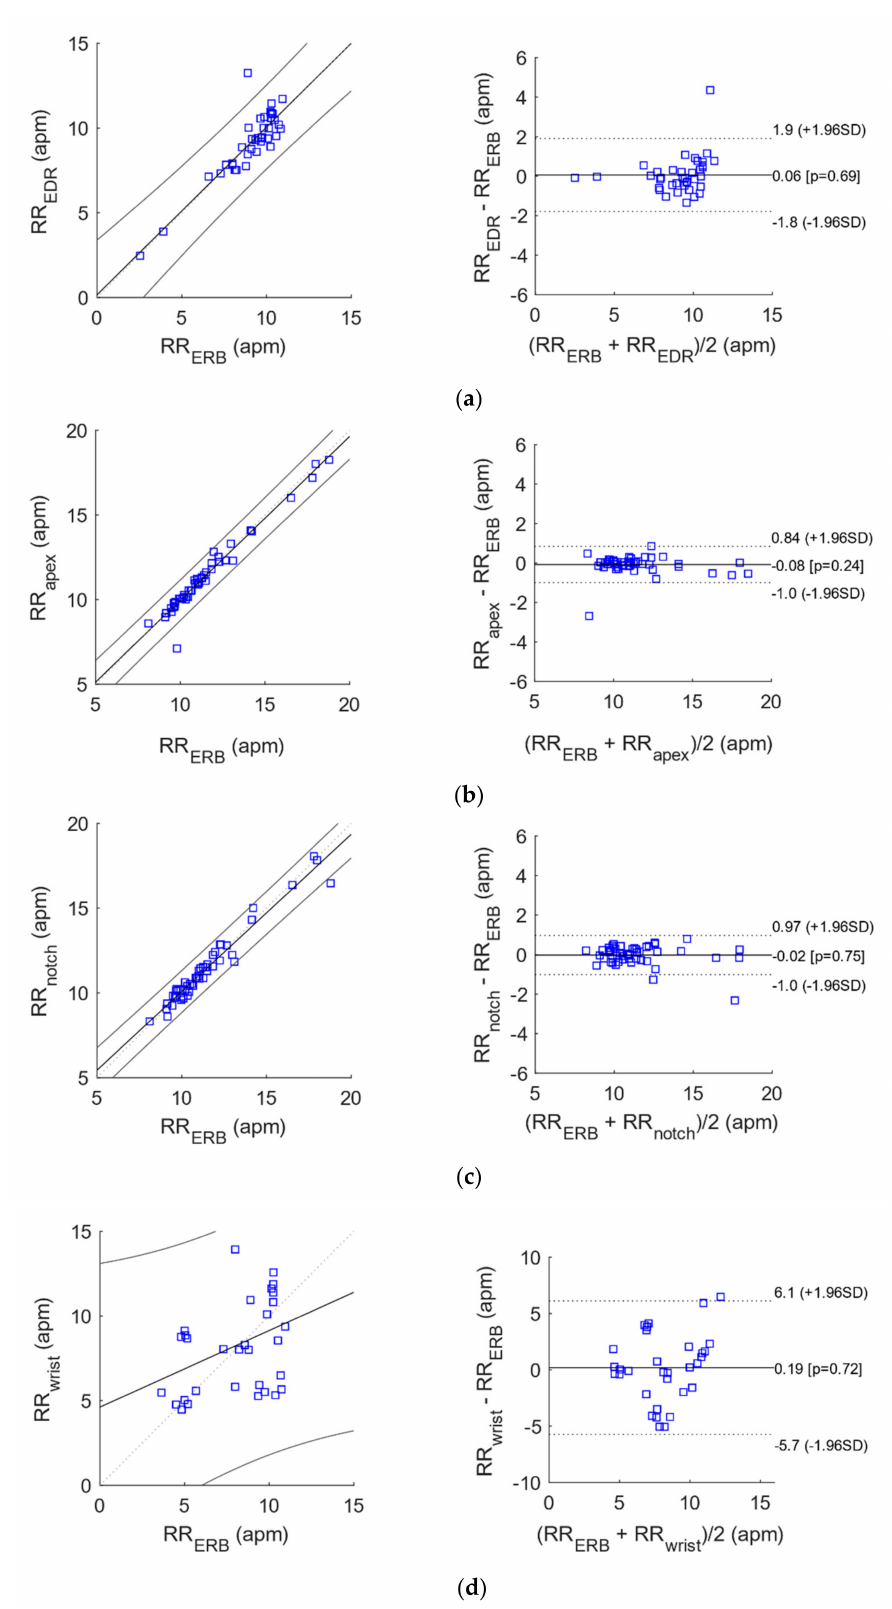
Figure 12. Correlation and Bland-Altman plots for the instantaneous respiratory rates extracted ECG versus those extracted from ( a ) EDR and ( b – d ) the heart monitoring signals acquired by the proposed sensor from heart apex, suprasternal notch and wrist,